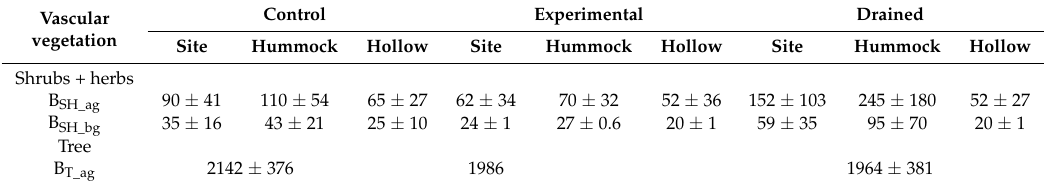
Table 3. Estimated aboveground biomass of shrubs + herbs (B SH_ag ) and trees (B T_bg ), and belowground biomass of shrubs + herbs and trees (B SH_bg ), at control, experimental, and drained sites *. All values (±SD) are in g ∙ m − 2 .